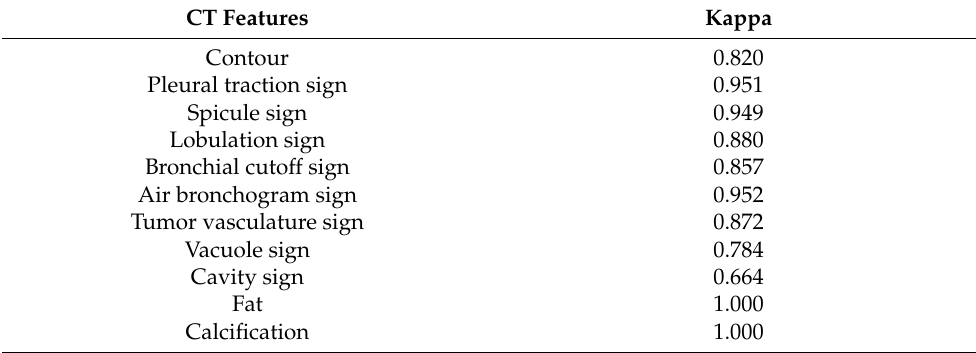
Table 1. Agreement for semantic features determined by two readers. CT Features